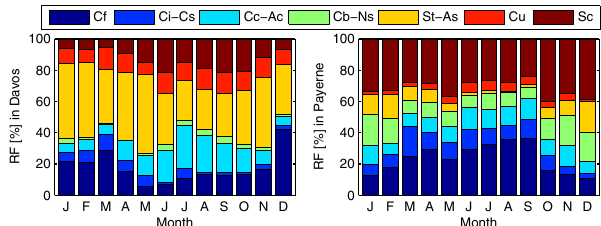
Figure 2. Relative frequencies (RF) of all cloud classes per month (all cloud coverages together) for the two stations Davos (left) and Payerne (right). Cf: cloud-free; Ci–Cs: cirrus–cirrostratus; Cc–Ac: cirrocumulus–altocumulus; Cb–Ns: cumulonimbus–nimbostratus; St–As: stratus–altostratus; Cu: cumulus; Sc: stratocumulus.